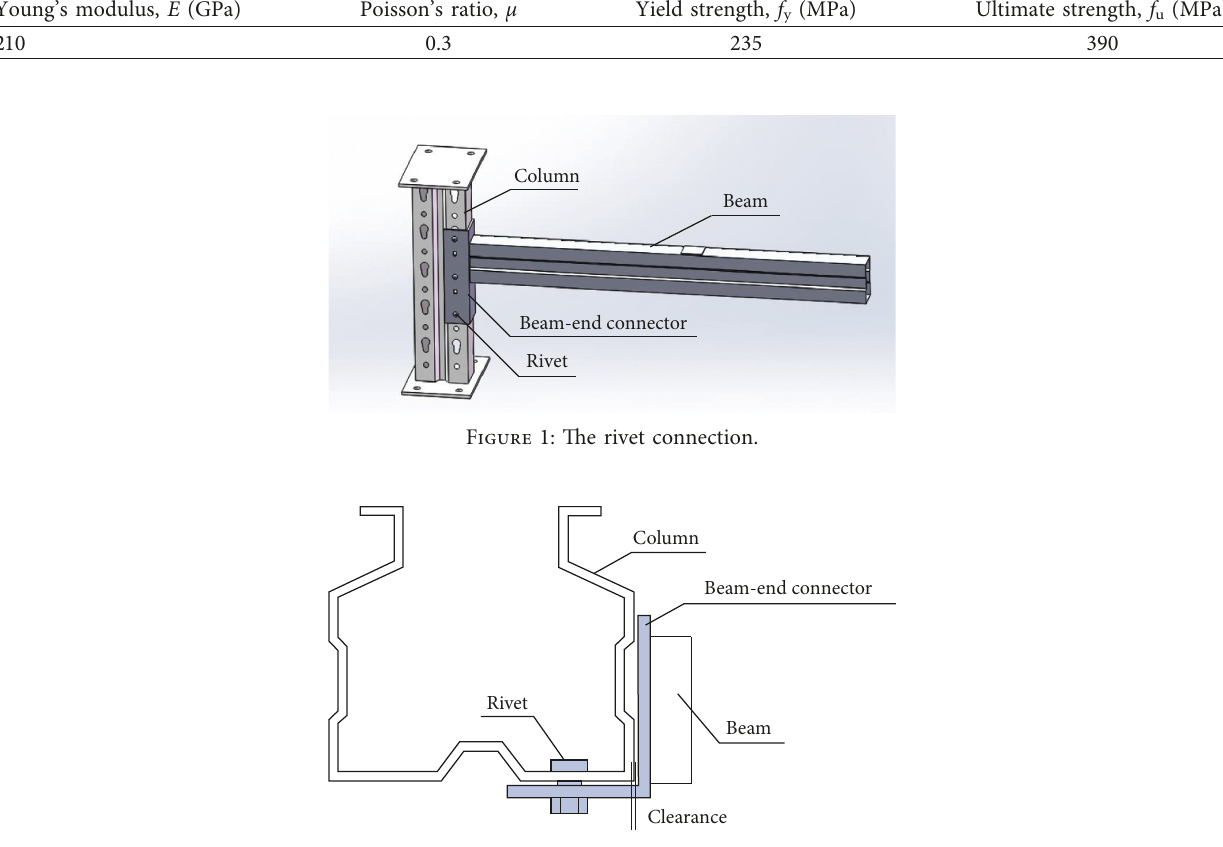
Figure 2: Details of the rivet connection.